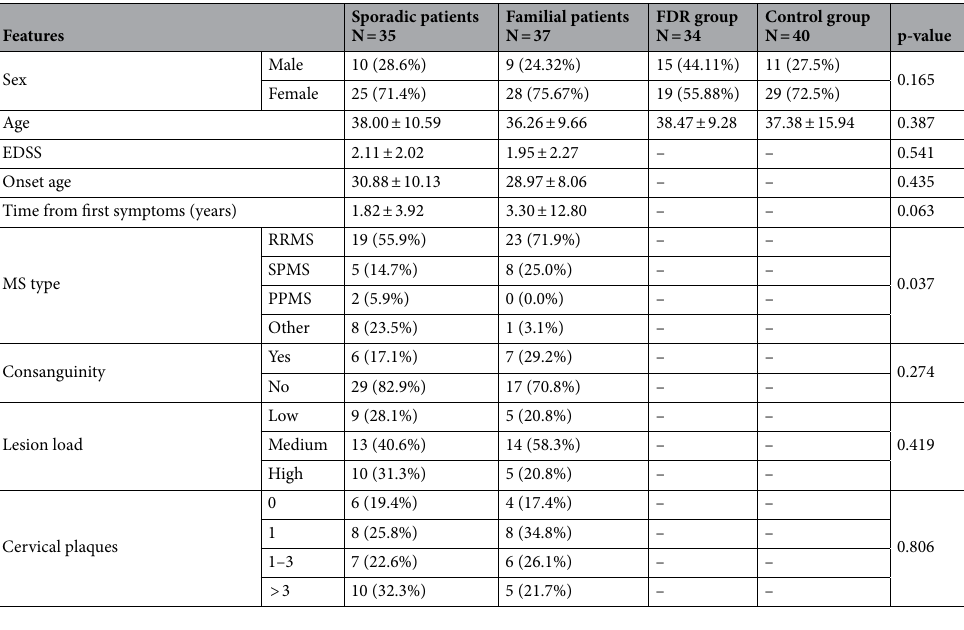
Table 1. Clinical characteristics of the participants in this study. Values are mean ± SD or number (percent). EDSS expended disability status scale, SD standard deviation, RRMS relapsing–remitting MS, SPMS secondary progressive MS, PPMS primary progressive MS, BMI body mass index.